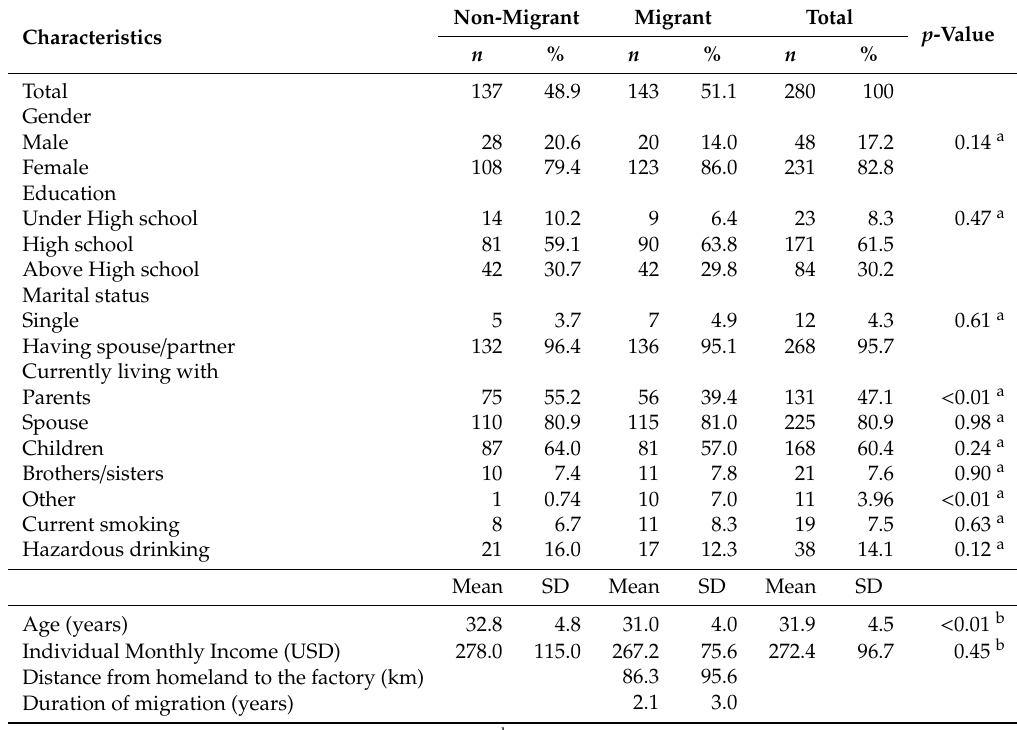
Table 1. Socio-economic status of